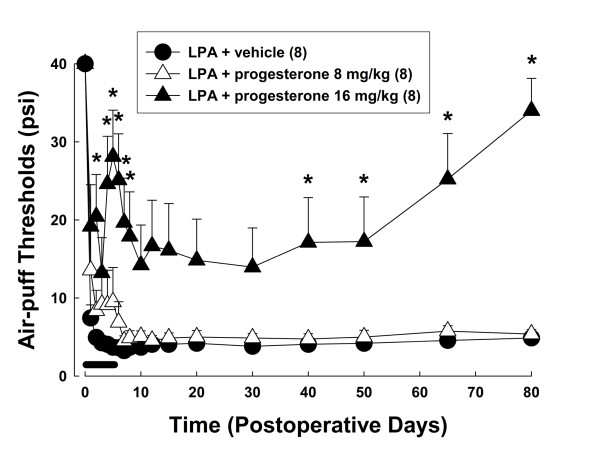
Delayed effects of progesterone treatment (8 or 16 mg/kg/day) on mechanical allodynia produced by the microinjection of LPA into the trigeminal nerve root. Progesterone-treated animals showed significant delayed anti-allodynic effects. The lines denote the period of five progesterone treatments. * P < 0.05, vehicle- vs. progesterone-treated group.